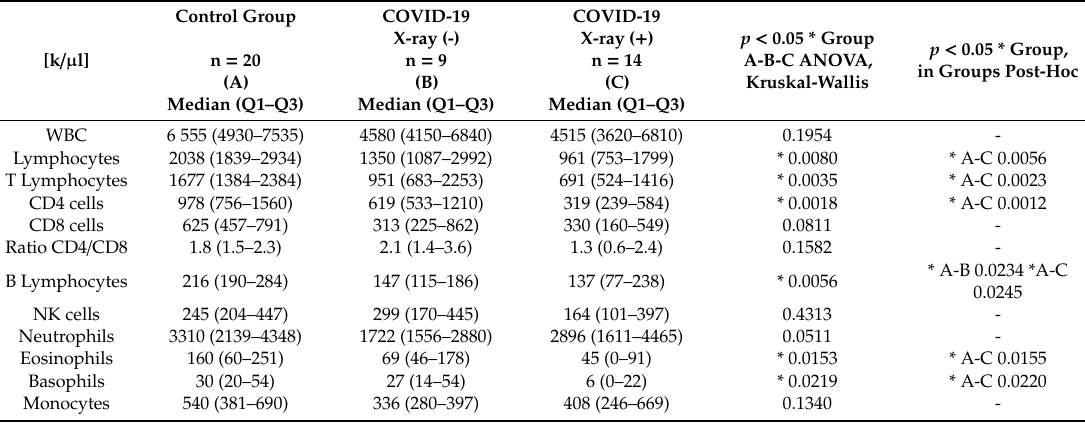
Table 2. Di ff erences in the median of white blood cells (WBC) count and leukocytes and main lymphocytes subpopulation counts between healthy patients ( A ), patients with COVID-19 without interstitial lesions on chest X-ray (( B ): COVID-19 X-ray ( − )) and patients with COVID-19 with interstitial lesions on chest X-ray (( C ): COVID-19 X-ray ( + )). Data expressed as median